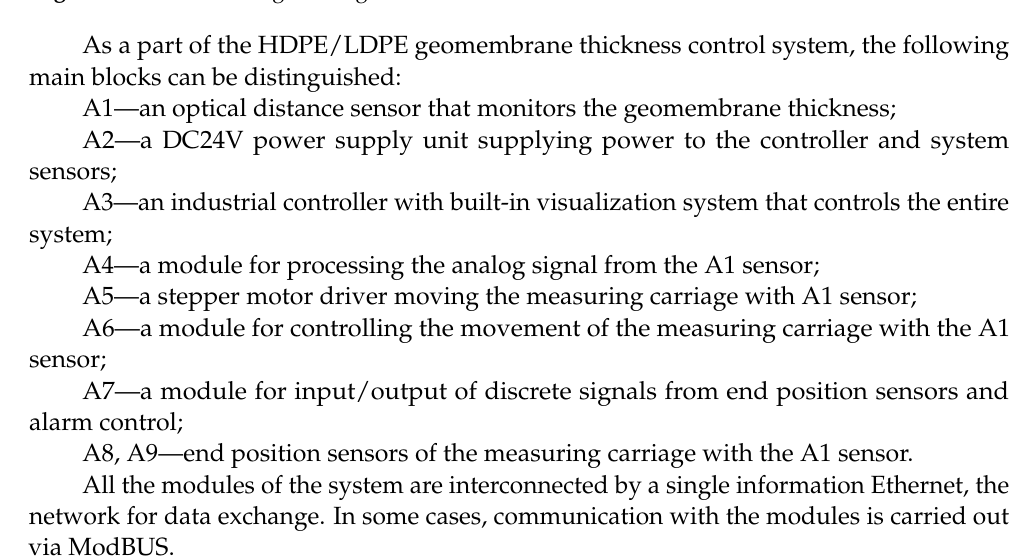
Figure 3. Functional diagram of geomembrane thickness control .